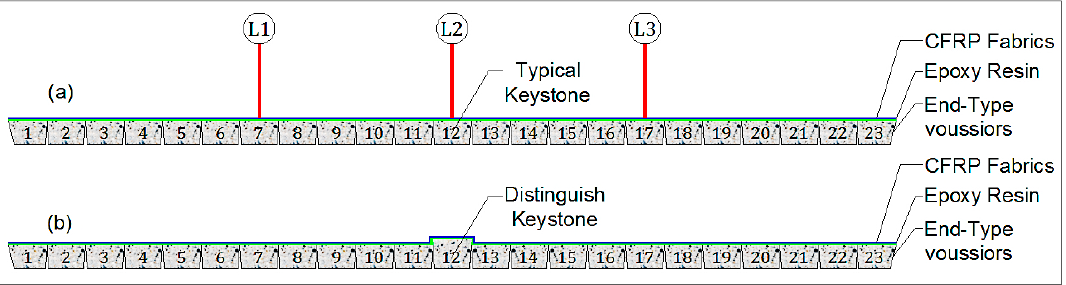
Figure 7. The self-form arch ready for forming, typical Keystone arch ( a ), distinguish Keystone arch ( b ).